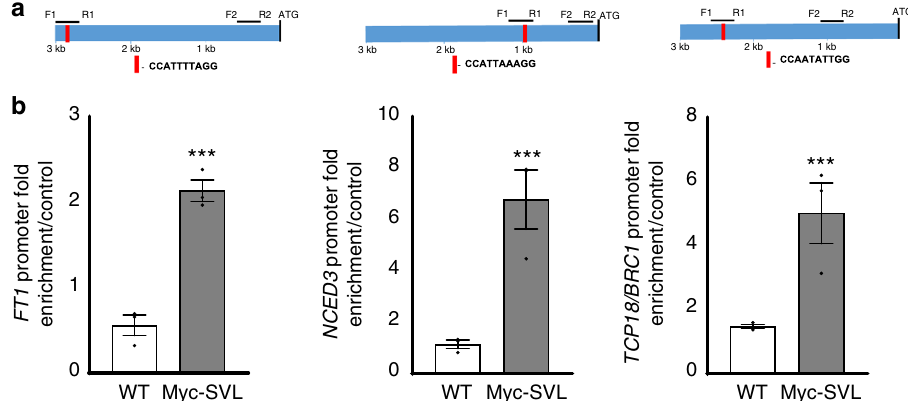
Fig. 4 SVL binds to FT1 , NCED3 , and TCP promoters in vivo in chromatin immunoprecipitation (ChIP) assays. a Diagrammatic representation of FT1 , NCED3 , and TCP18 / BRC1 promoters showing the CArG motif and their positions within a 3 kb region. F1 – R1 indicates positions of DNA fragments used to assess DNA – protein interactions in ChIP assays, and F2 – R2 indicates positions of DNA fragments with no CArG motif used as negative controls in the assays. b Enrichment of the DNA fragments containing the CArG motif quanti fi ed by ChIP-q-PCR. Presented values were fi rst normalized by their respective input values, then fold enrichments in WT and Myc-SVL plants relative to negative controls were calculated. Bars show an average values from three independent biological replicates± SEM. Asterisks indicate signi fi cant (* P < 0.05), very signi fi cant (** P < 0.005) and extremely signi fi cant (*** P < 0.001) differences from corresponding controls, respectively. Statistical analysis was done using t